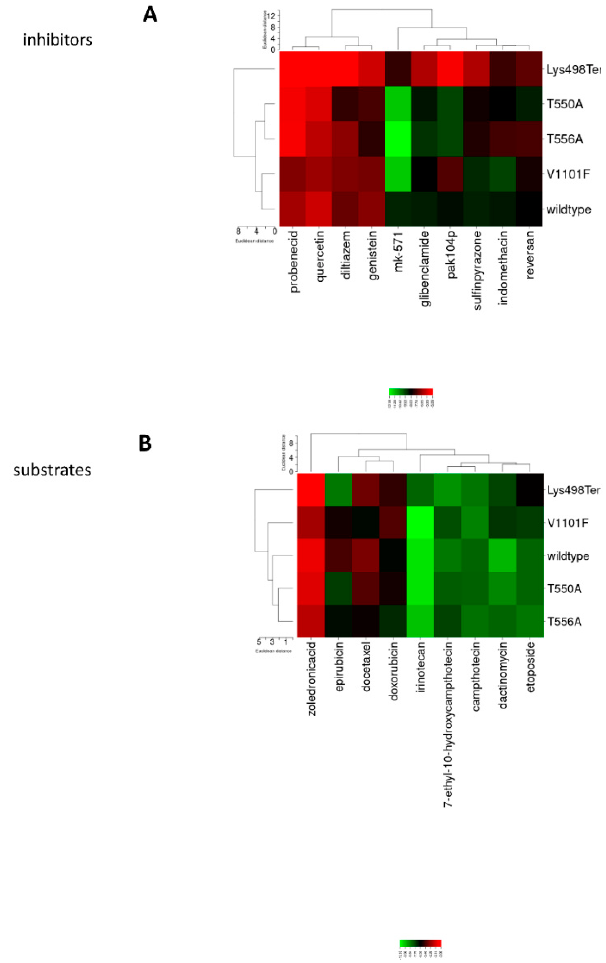
Figure 3. Heat maps for the docking analyses of ( A ) MRP1 inhibitors, ( B ) MRP1 substrates (green color: strong interaction; red color: weak interaction) on wild-type and mutant MRP1.